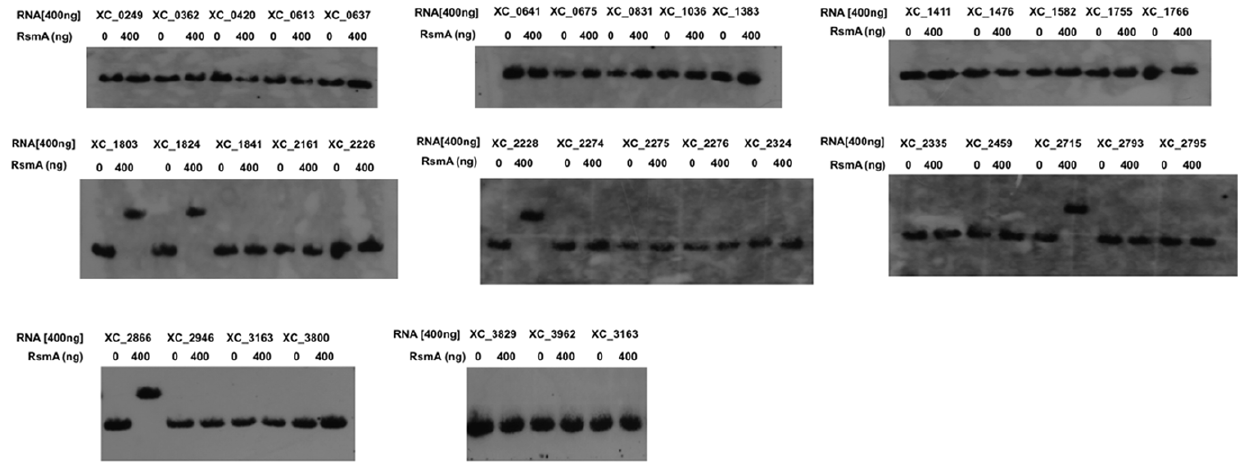
Figure 3. RsmA directly interacts with the transcripts of XC_1803,XC_1824,XC_2228,XC_2715 and XC_2866. Electromobility shift assays were used to assess interaction between purified RsmA and in vitro synthesized transcripts of approximately 500 bp comprising the upstream region and a small part of the coding region of all genes that encode GGDEF, EAL or HD-GYP proteins (see Methods for specific details). These analyses revealed interactions of RsmA with transcripts of XC_1803, XC_1824, XC_2228, XC_2715 and XC_2866 . The concentration of RNA used (400 ng) is indicated at the top of the appropriate lanes.